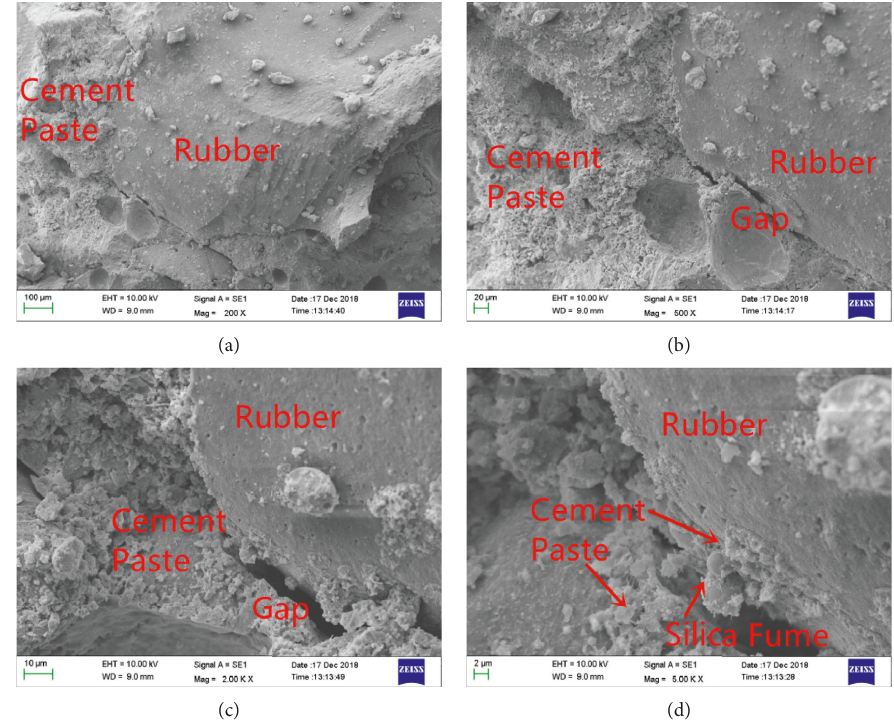
Figure 13: Microstructure of RC40SF10 concrete at (a) 200x, (b) 500x, (c) 2.00kx, and (d) 5.00kx